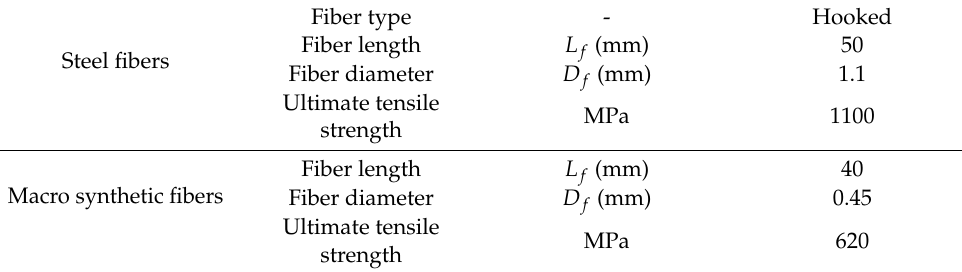
Table 2. Properties of fibers as supplied by the manufacturer [22].